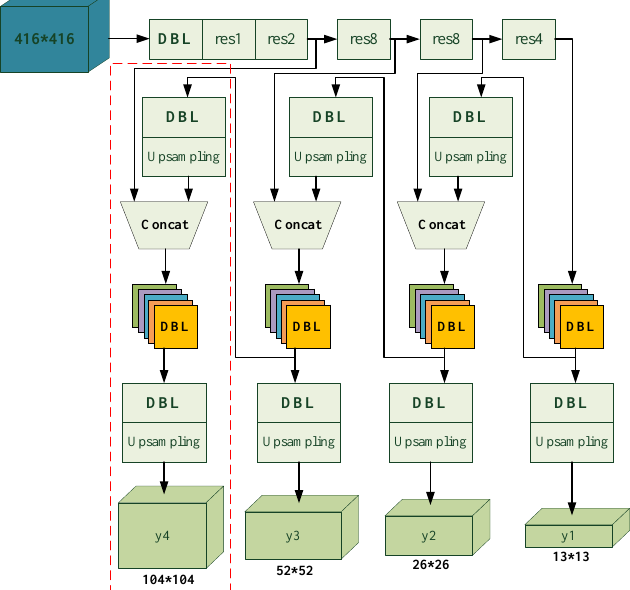
Figure 2. The improved YOLOv3